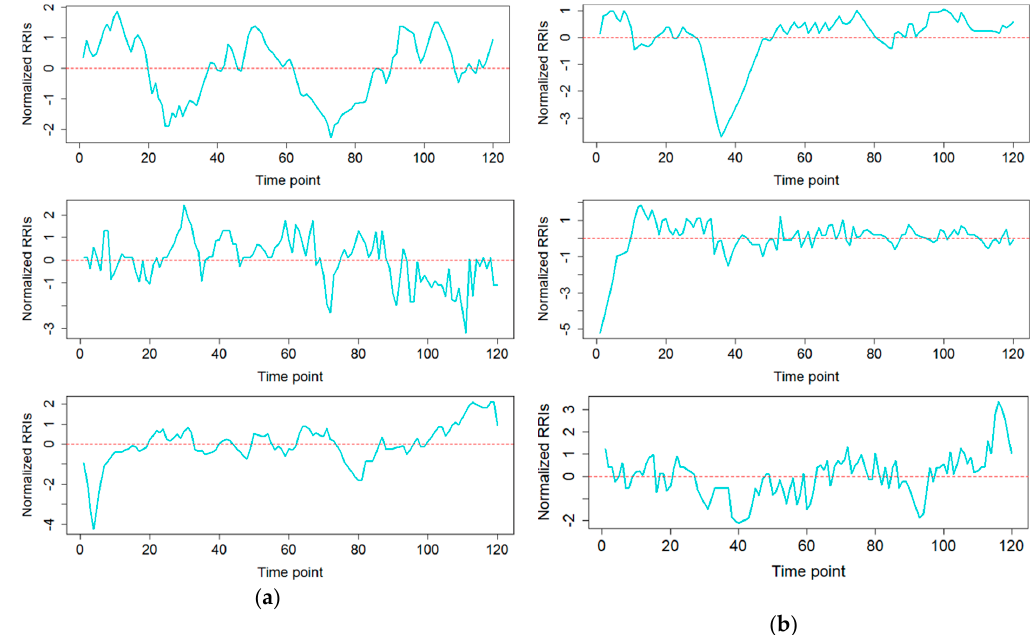
Figure 6. Some examples of 2-min RRI samples obtained from a photoplethysmogram (PPG) (band) sensor: ( a ) drowsy state; ( b ) awake state.